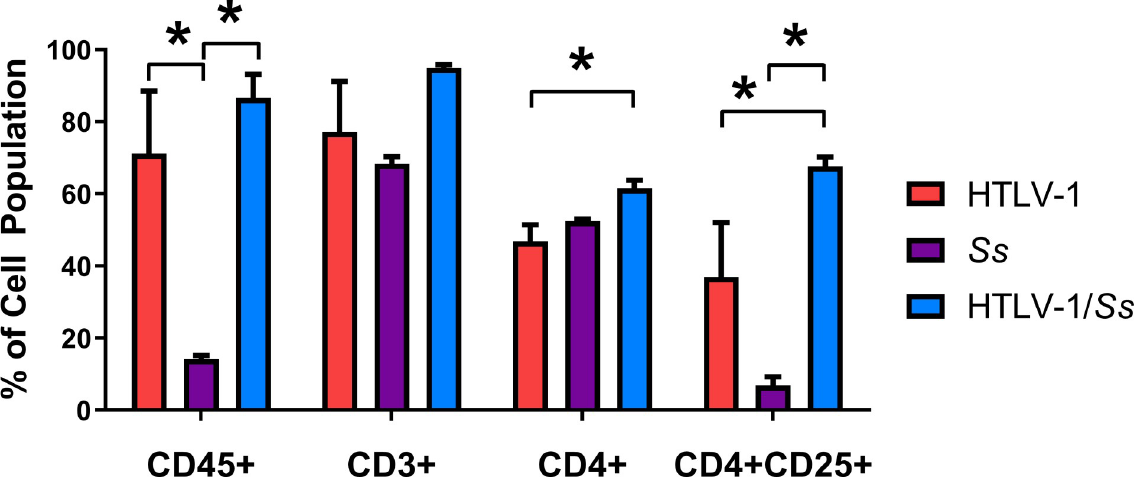
Fig 6. Composition of the human immune cells from peripheral blood in humanized NSG mice during HTLV-1 and Strongyloides stercoralis (Ss) co infection taken at 2-weeks post-infection with S . stercoralis . Human lymphocytes were stained with mouse anti-human CD45, CD3, CD4, CD8, and CD25 and analyzed by flow cytometry. Asterisk represents p <